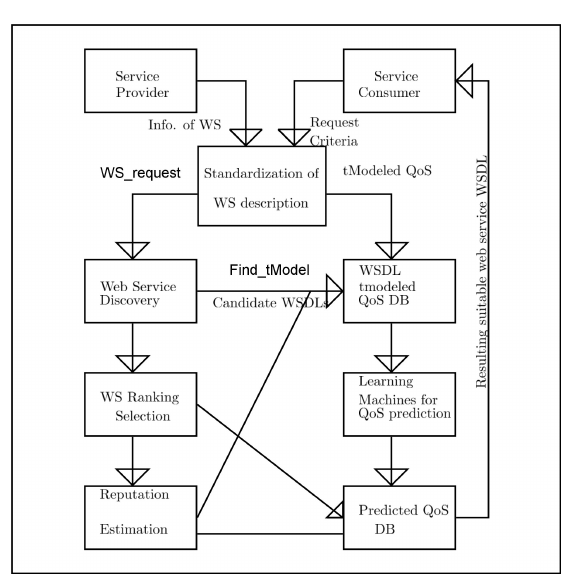
Figure 1. Architecture for Web service discovery